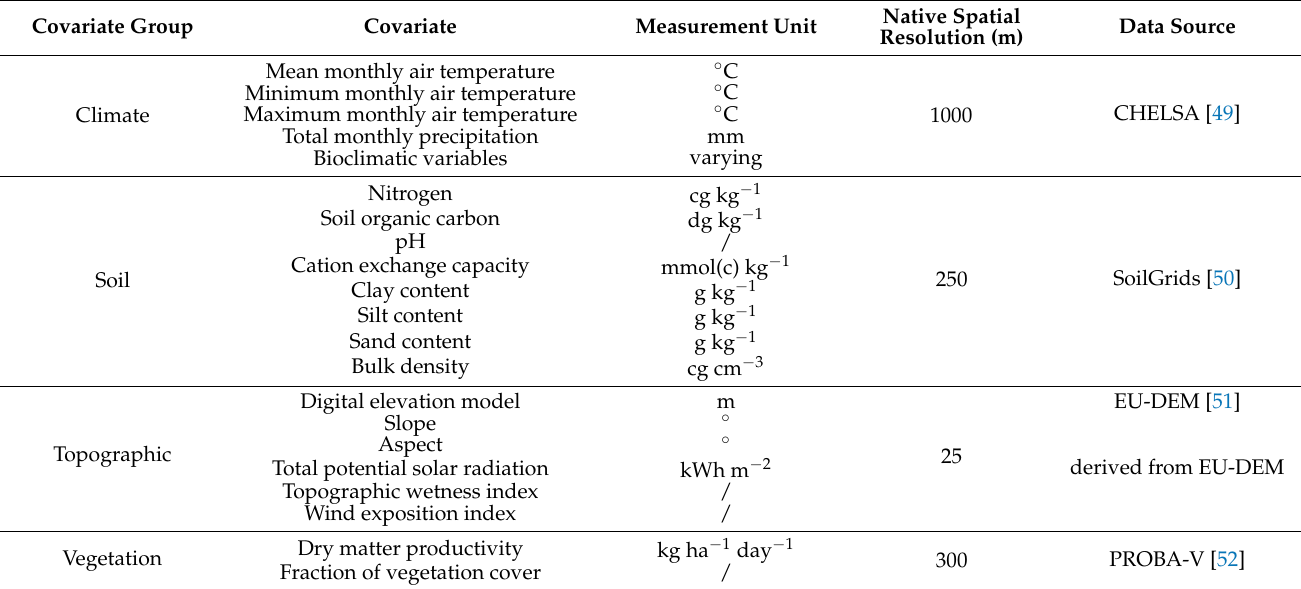
Table 2. A generalized description of covariates used in the